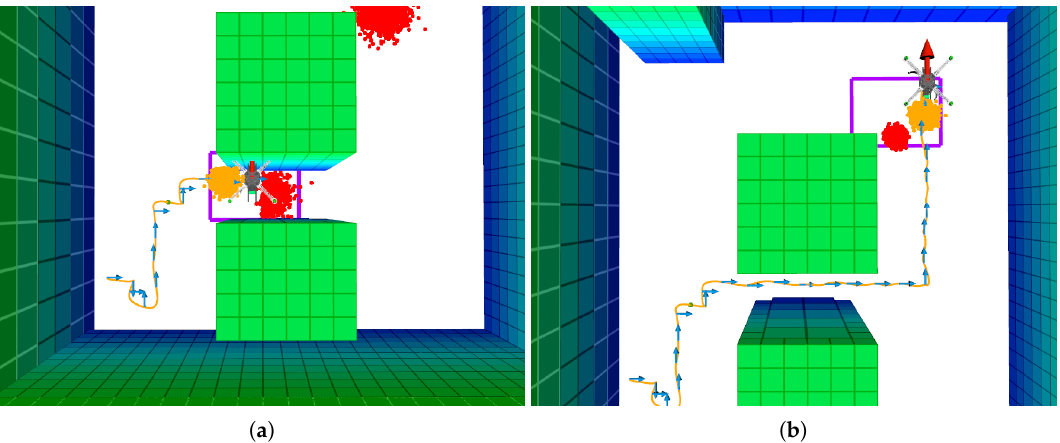
Figure 11. Flight mission example trajectory under two defined belief clusters. ( a ) UAV motion policy status when it reached the first cluster. ( b ) UAV motion policy after clearing the first cluster and reaching the second cluster.